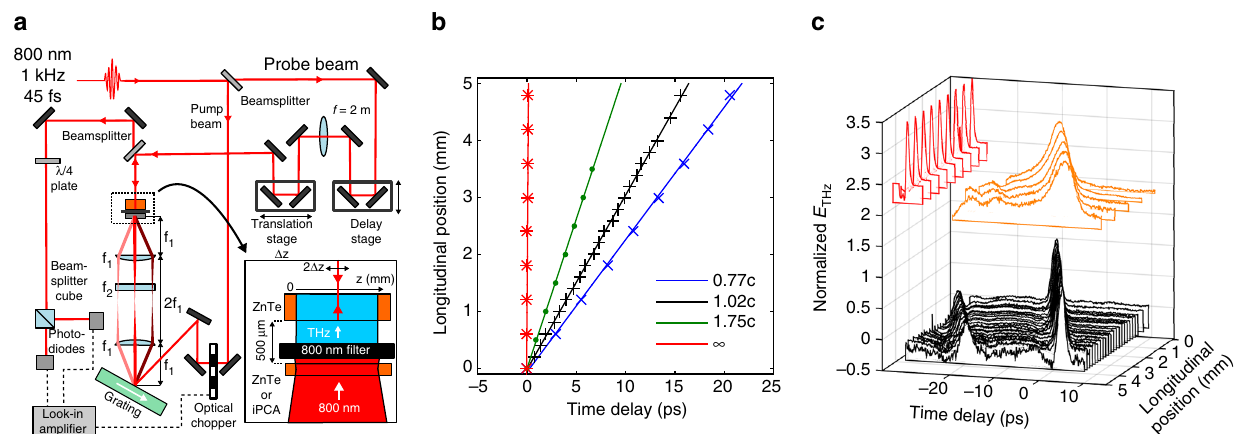
Fig. 3 Experimental measurements of the terahertz emission from a travelling source. a Experimental arrangement for the spatial and temporal characterisation of the terahertz pulse emitted from a ZnTe or interdigitated photoconductive antenna (iPCA) travelling wave source. b World lines of the terahertz pulse measured for a ZnTe source with differing pulse-front tilts. The data points are the time of the peak electric fi eld. The lines are linear fi ts to the data, and correspond to phase and group velocities from 0.77 c to 1.75 c . c Examples of the single-cycle terahertz pulse temporal pro fi les measured at positions in a plane parallel to the emitting surface. The longitudinal direction is de fi ned as the direction of propagation of the travelling wave source. From top to bottom , the pulses were generated by a planar wavefront optical pulse exciting a ZnTe emitter ( v eff = ∞ ), and θ tilt ~ 45° pulse front exciting an